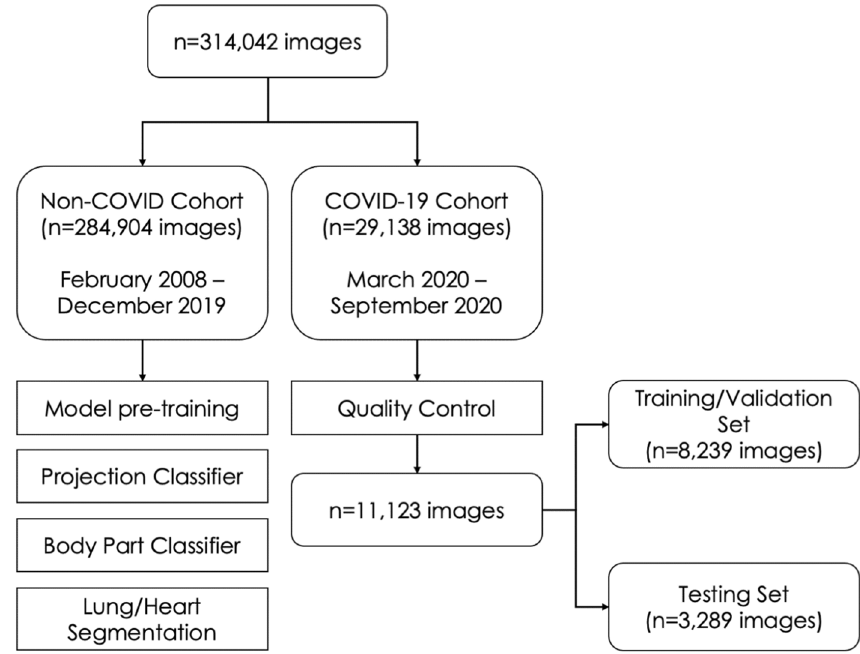
Figure 1. Dataset Characteristics. Entire dataset comprised of Non-COVID (n = 284,904) and COVID-19 (n = 29,138) cohorts. Images in the non-COVID cohort (collected between February 2008 and December 2019) were used to pre-train all classifiers and generate Projection and Body Part classifiers, as well as the Lung and Heart Segmentation model. Images in the COVID-19 cohort (collected between March 2020 and September 2020) have undergone rigorous Quality Control process and were used to train and test the COVID-19 Ensemble.